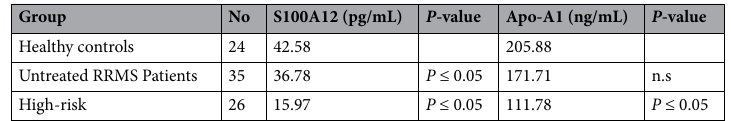
Table 2. The mean concentration of S100A12 and Apo-A1 plasma levels quantified by ELISA.